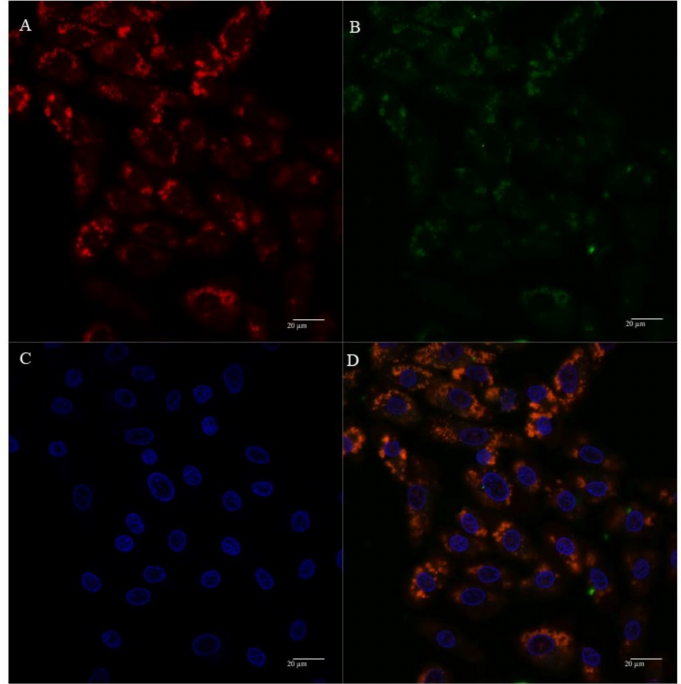
Figure 8. Representative confocal fluorescence image of HeLa cells, illustrating the transfection ability and intracellular co-localization of MTS-WRAP5/pND1 complexes formulated at an N/P ratio of 5. Mitochondria stained red by MitoTracker ( A ), pND1 green, labeled ( B ), nucleus marked blue by DAPI ( C ), and merged image ( D ). Scale bar = 20 µ